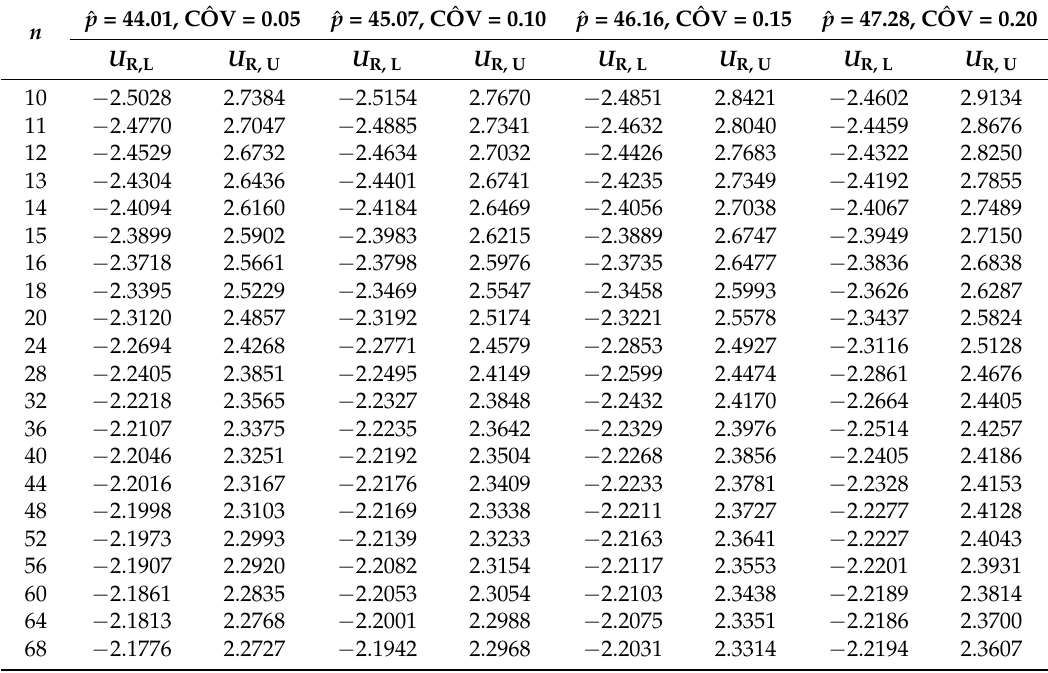
Table 2. Two-side percentage points U R, L and U R, U